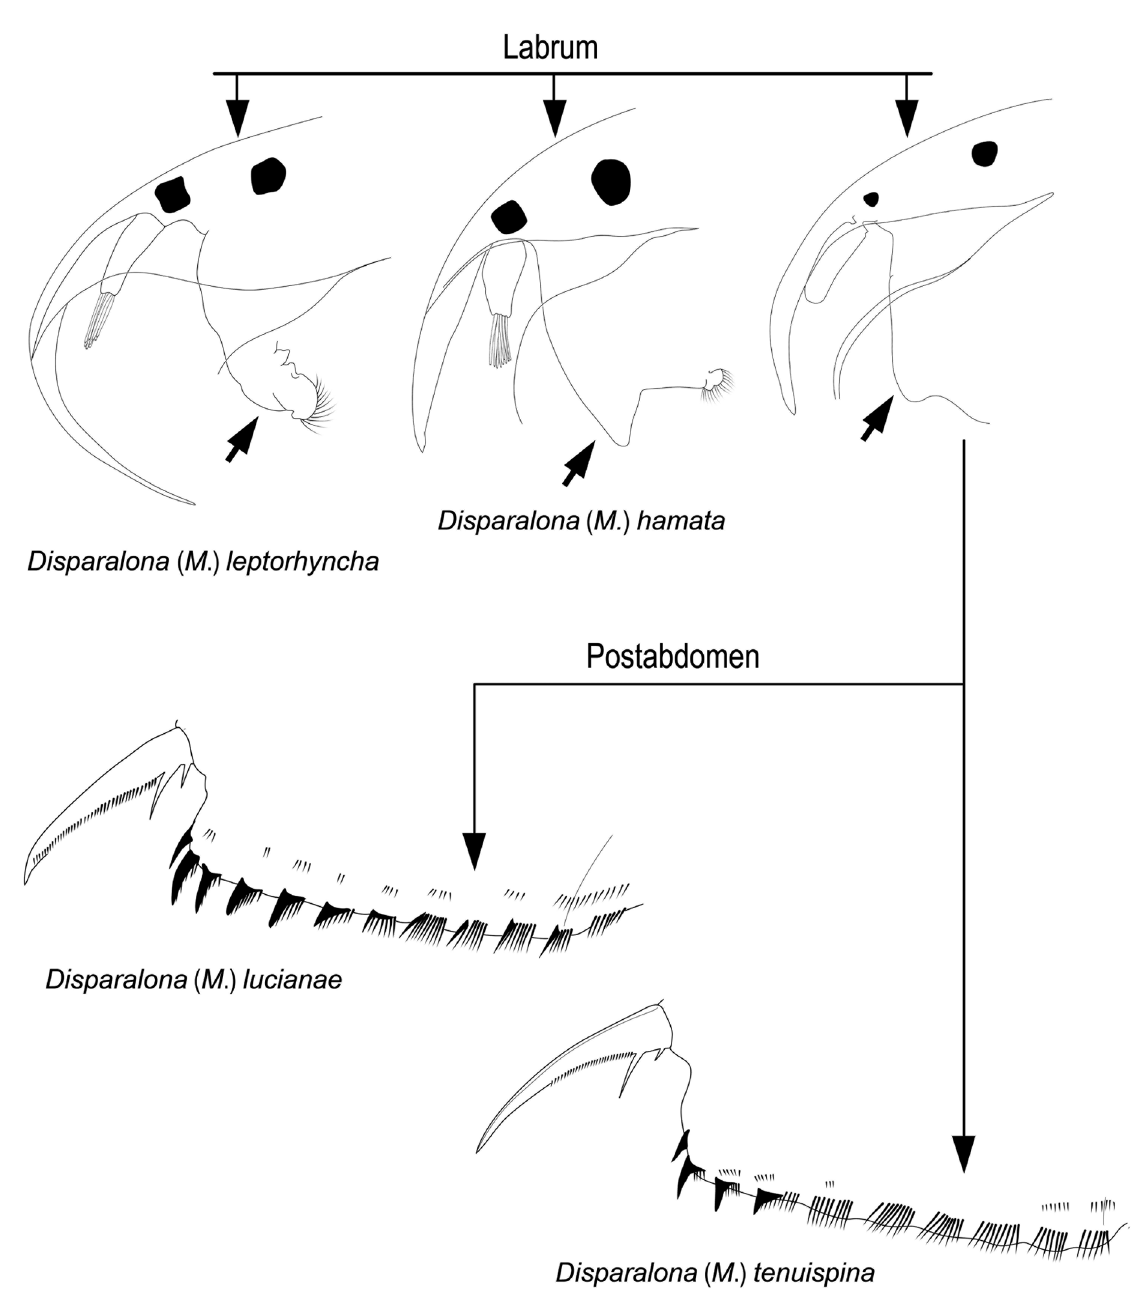
Fig. 13. Pictorial key to separation of species of Disparalona Fryer, 1968 occurring in South